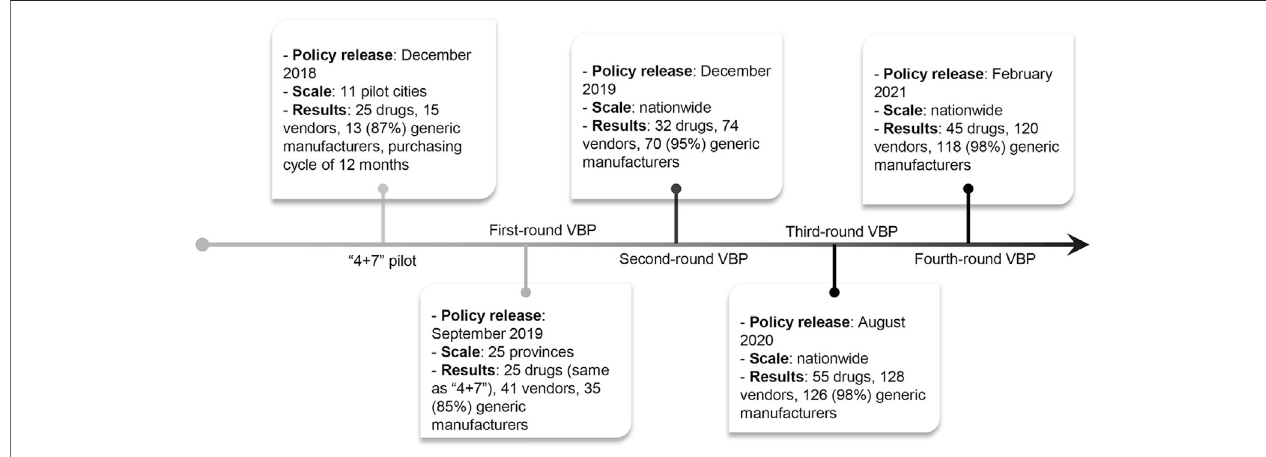
FIGURE 1 | Timeline of the volume-based procurement reform. 11 pilot cities include 4 municipalities (i.e., Beijing, Tianjin, Shanghai, and Chongqing) and 7 cities (i.e., Shenyang, Dalian, Xiamen, Guangzhou, Shenzhen, Chengdu, and Xi ’ an).